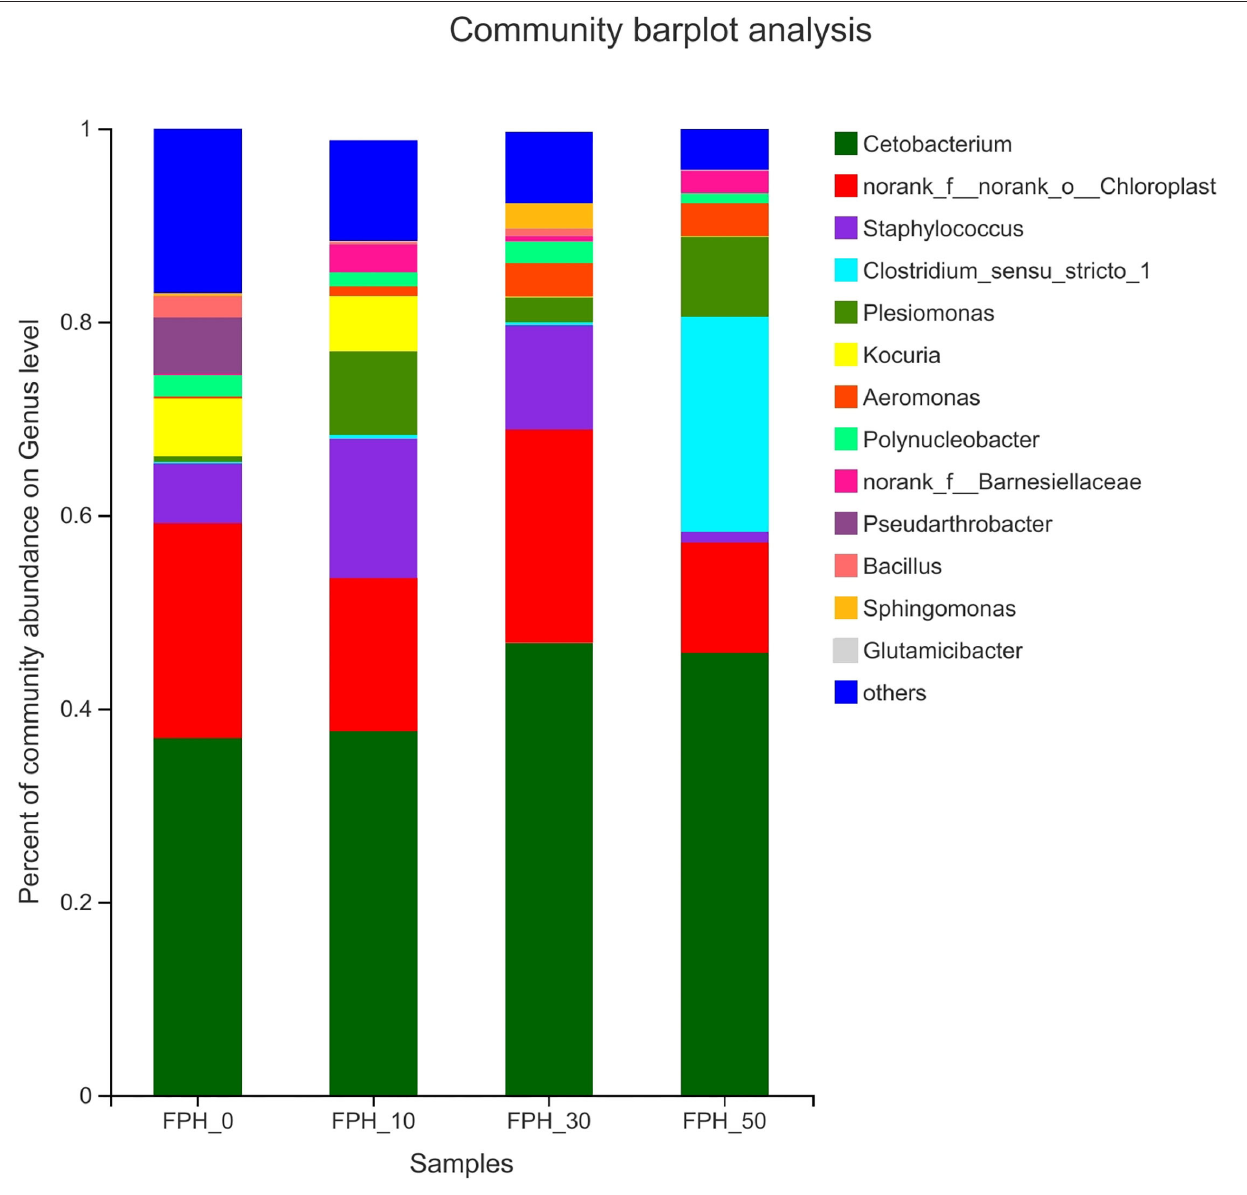
Frontiers in Nutrition |